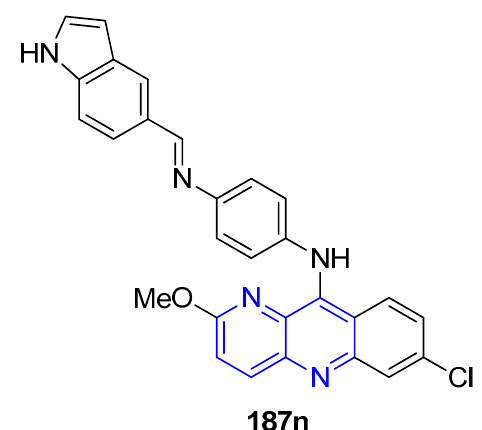
Figure 19. Activity of 187n against Nippostrongylus brazilliensis .